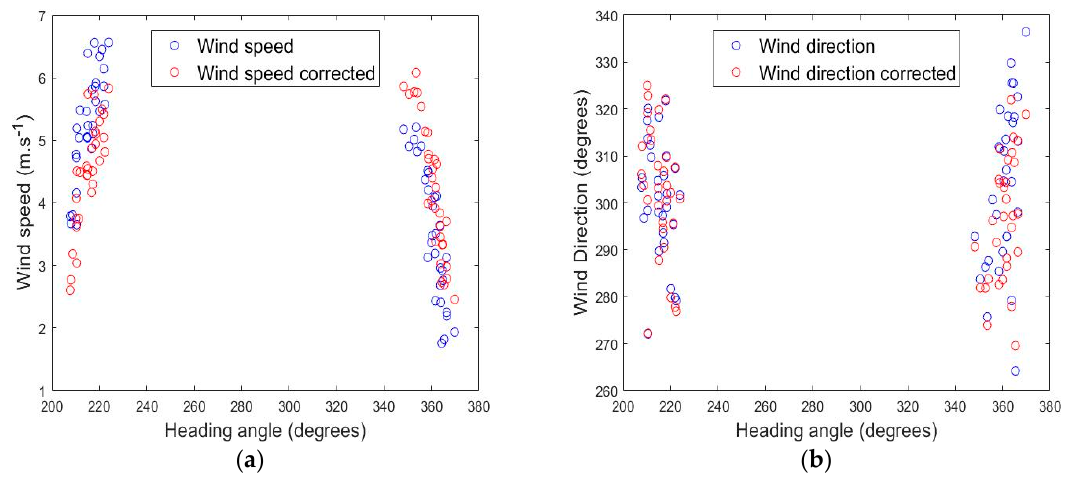
Figure 11. Wind speed ( a ) and wind direction ( b ) as a function of heading angle, estimated on the 61 flight sequences before (in blue) and after (in red) the bias correction.